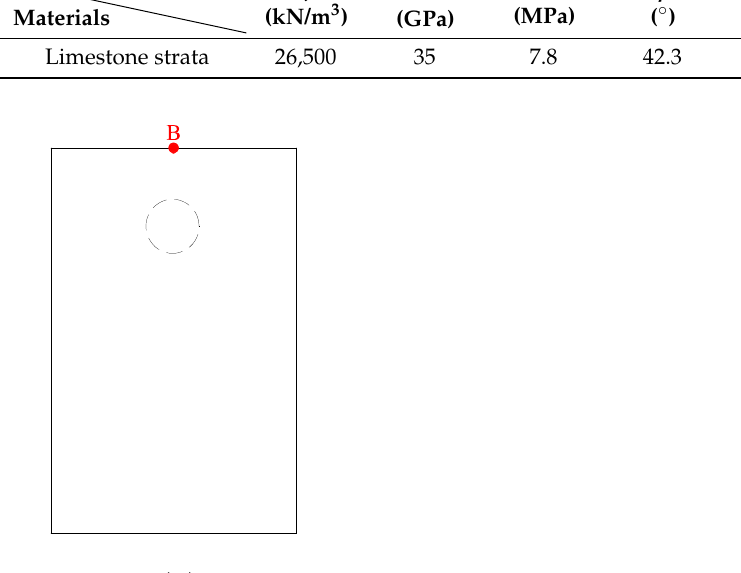
Figure 9. Sketch of monitored point layout. ( a ) vertical cross-section; ( b ) horizontal cross-section. Table 1. The spatial geometry parameter and the attribute parameter.